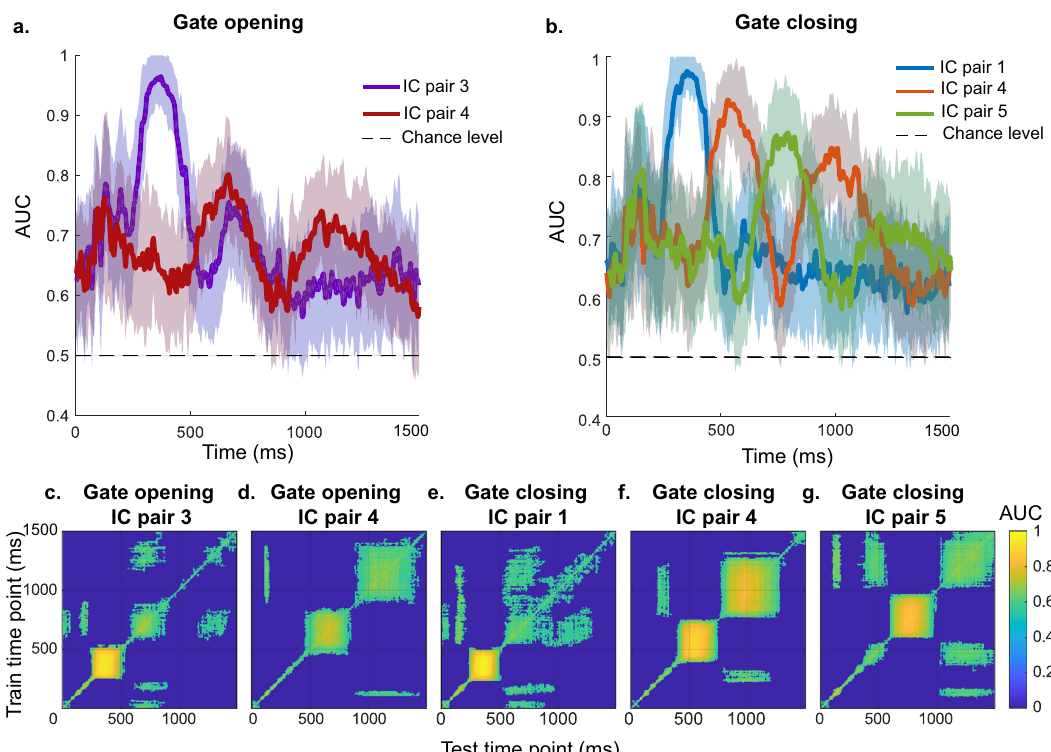
Fig. 3 MVPA results for selected independent component (IC) pairs of gating conditions. Plots a and b show the binary classi fi cation performance of gate opening and closing conditions separately. The shaded error bars represent standard deviation. Plots c – g illustrate the temporary generalization of each IC pair. Only time points with signi fi cant ( p < 0.05) classi fi cation performance computed by cluster-based permutation test with N = 33 samples are presented in